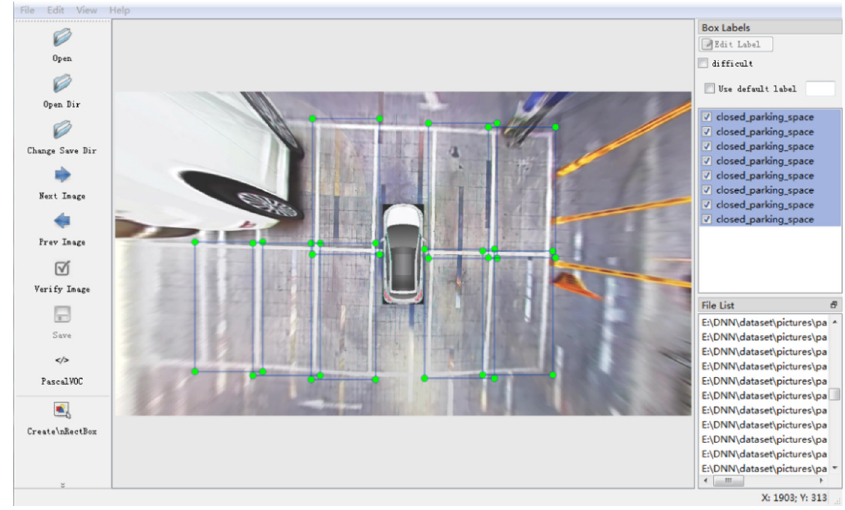
Figure 15. Parking space identification.